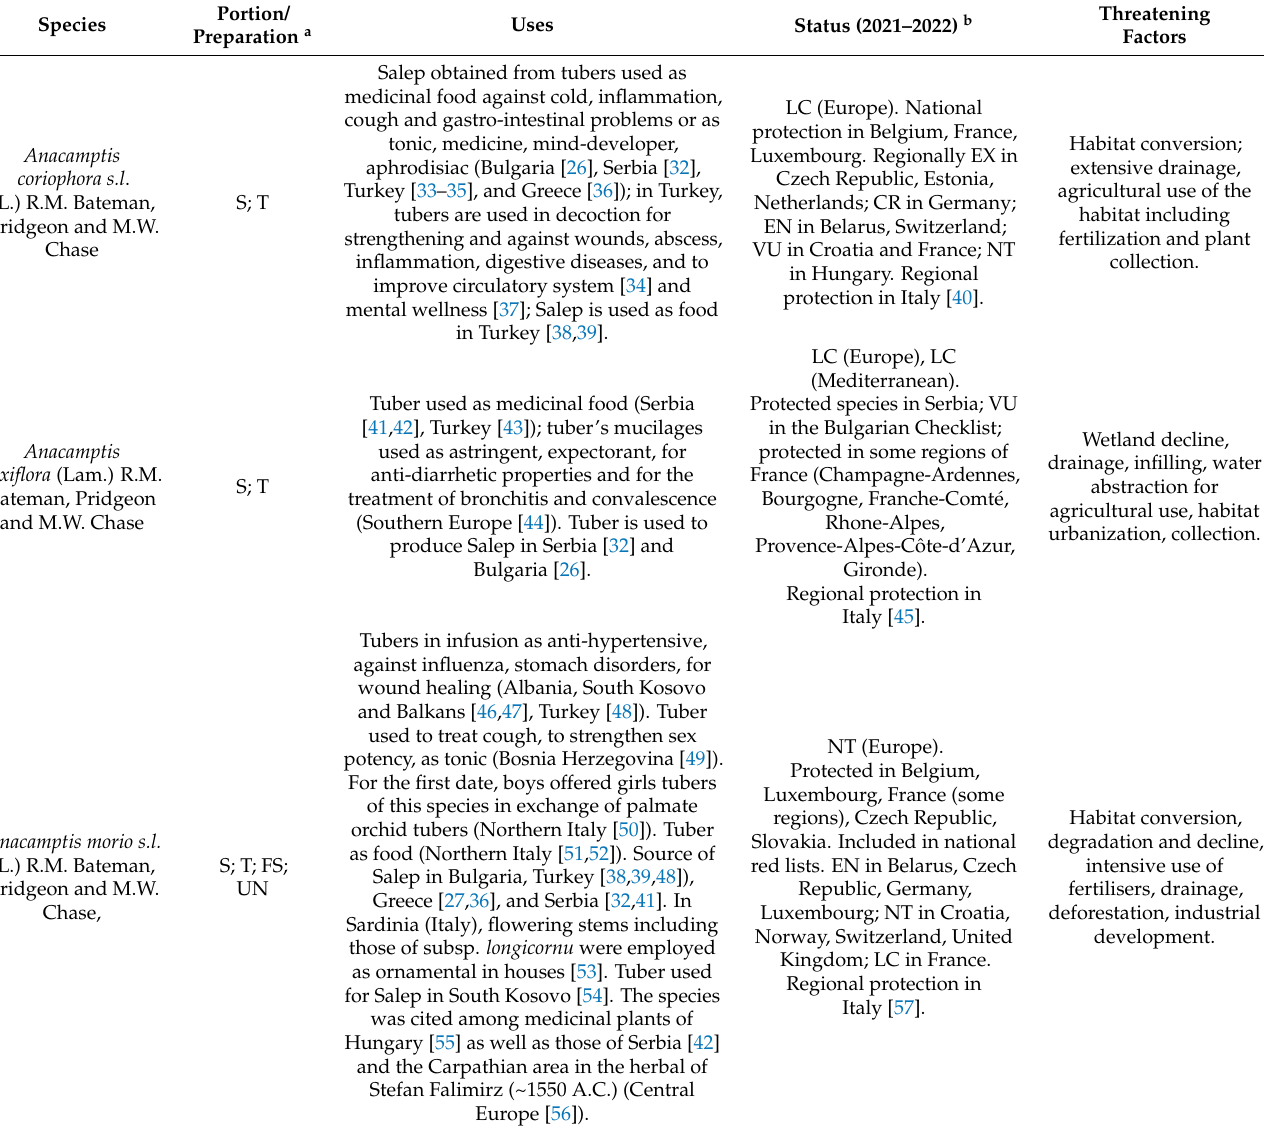
Table 1. Traditional uses and conservation status of orchids distributed in Europe and Mediterranean.